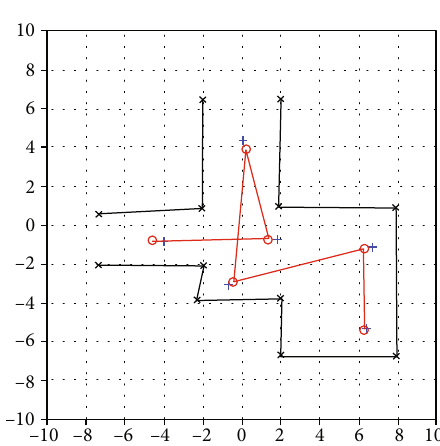
Figure 13: Experiment 3 environment